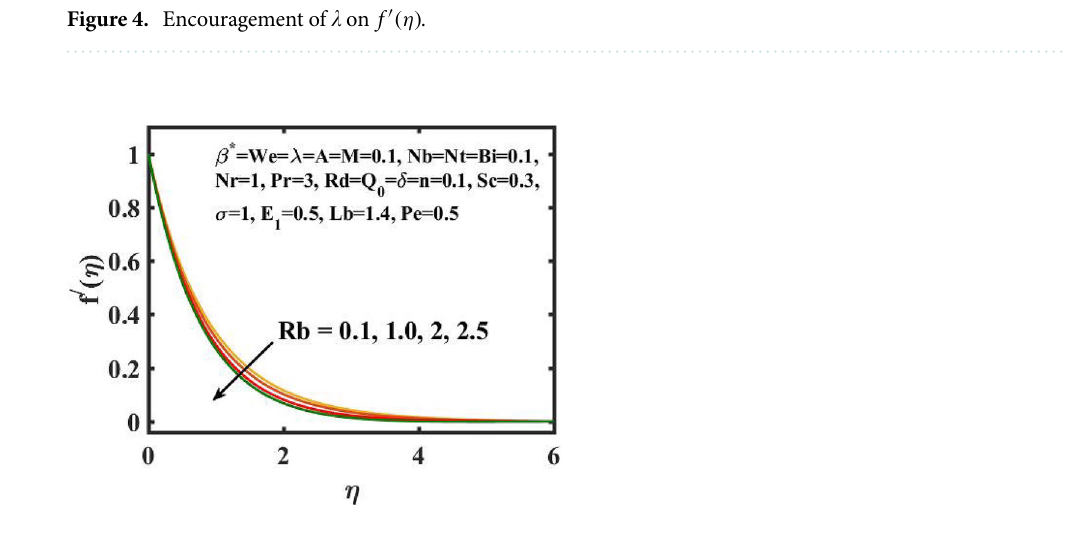
Figure 5. Encouragement of Rb on f ′ (η)